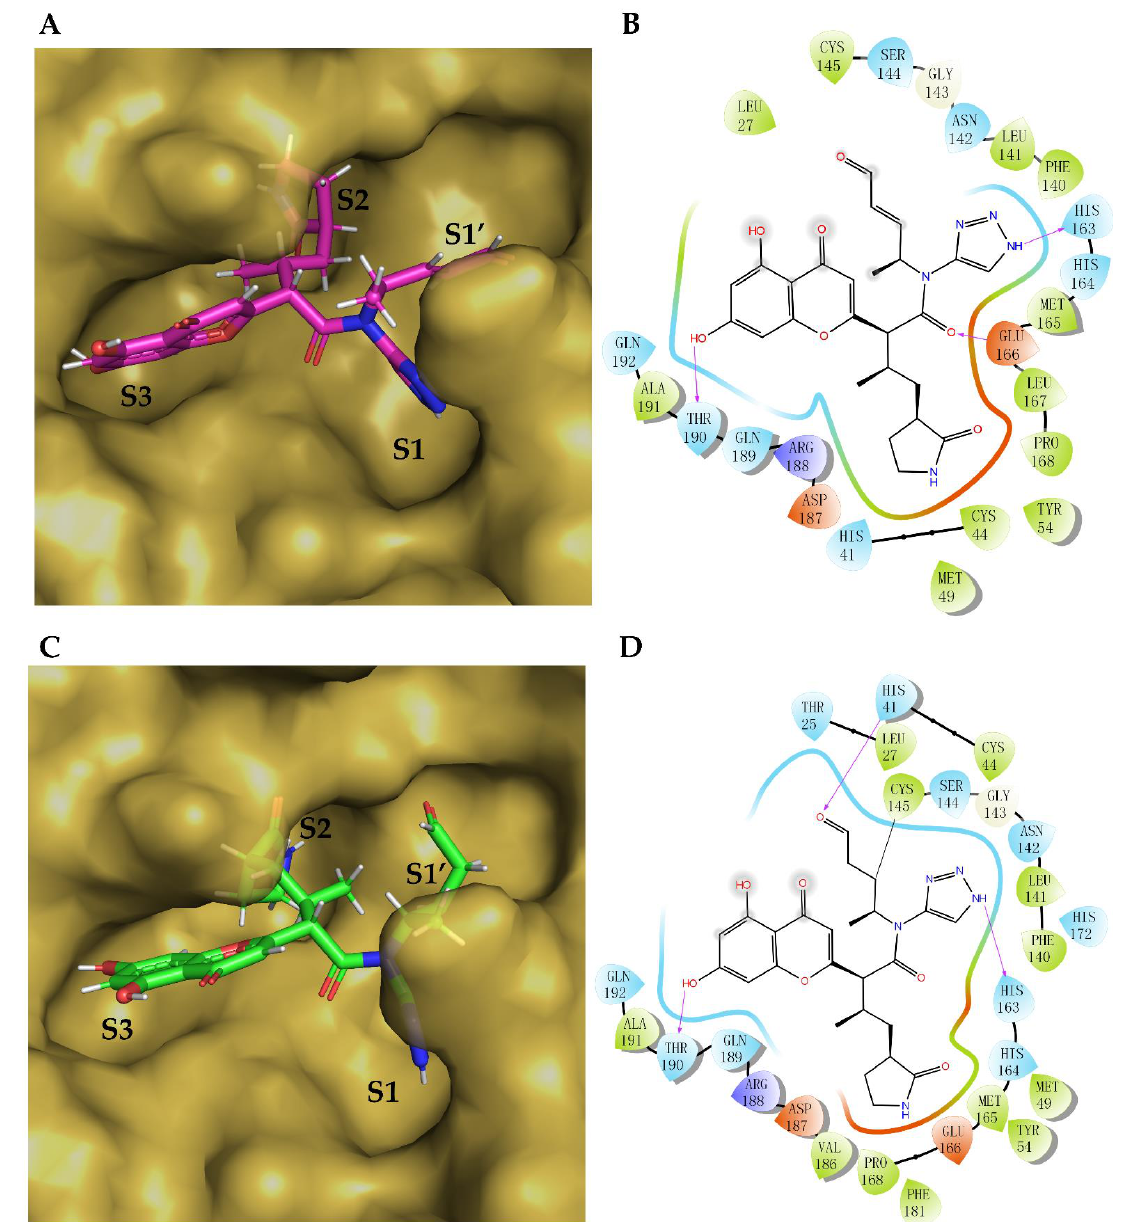
Figure 3. Lead compound # 46 generated by AI. ( A ) Non-covalent docking model of SARS-CoV-2 3CL pro (brown surface) with the bound lead compound # 46 (magenta sticks). The triazole ring binds to the S1 subsite of the active catalytic center, the covalent fragment of the α, β-unsaturated aldehyde binds to the S1’ subsite, the β-lactam ring binds to the S2 subsite, and 5,7-dihydroxy chromone binds to the S3 subsite. ( B ) Two-dimensional (2D) view of the non-bonding interactions of lead compound # 46 in complex with 3CL protease based on non-covalent docking. The triazole ring, ketoamide group, and phenolic hydroxyl group form hydrogen bonds (H-bonds) with His163, Glu166, and Thr190, respectively. ( C ) Covalent docking model of compound # 46 (green sticks) with 3CL protease (brown surface), similar to the non-covalent docking model. ( D ) Two-dimensional view of ligand interactions between compound # 46 and protease under covalent docking. The triazole ring forms an H-bond with His163. The α , β -unsaturated aldehyde forms a covalent bond with Cys145, i.e., the key residue in the catalytic center of the protease, resulting in covalent inhibition. The aldehyde carbonyl group forms an H-bond with His41. The hydroxyl group of chromone at position 7 forms an H-bond with